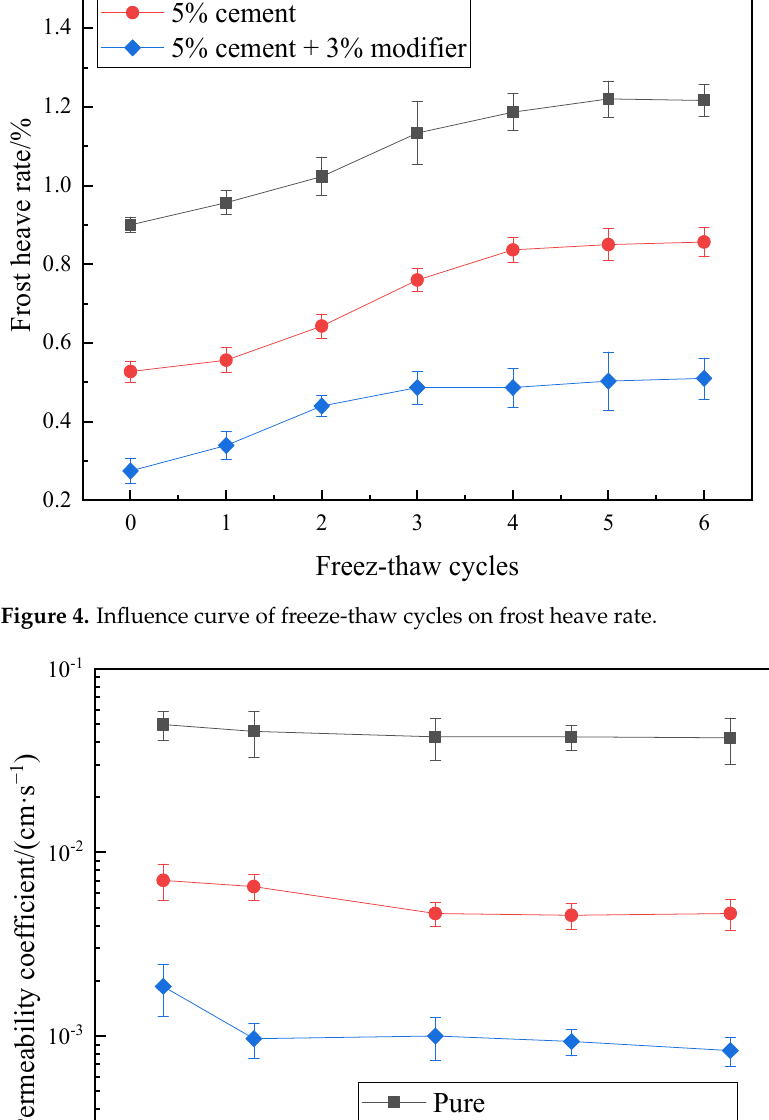
Figure 4. Influence curve of freeze-thaw cycles on frost heave rate.